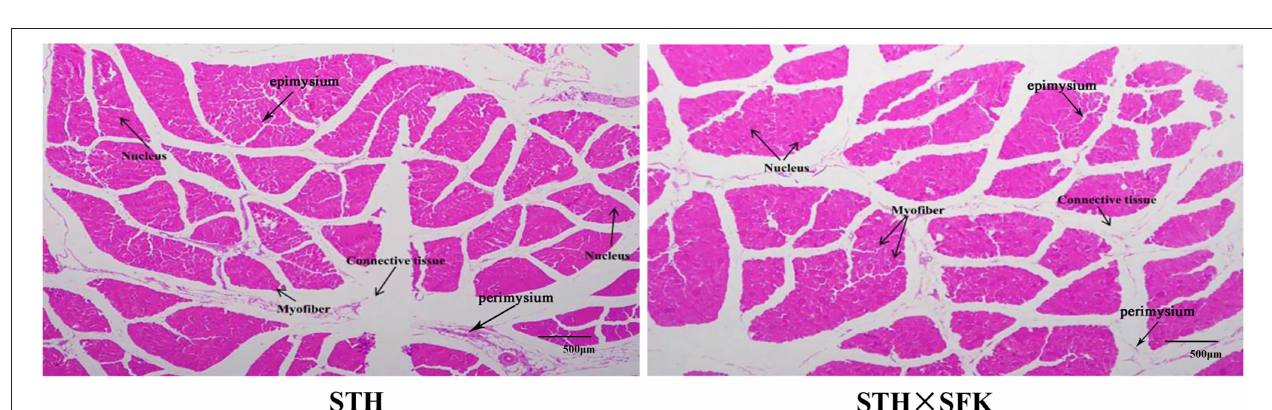
FIGURE 1 | The difference in production performance and meat quality of STH and STH × SFK sheep.